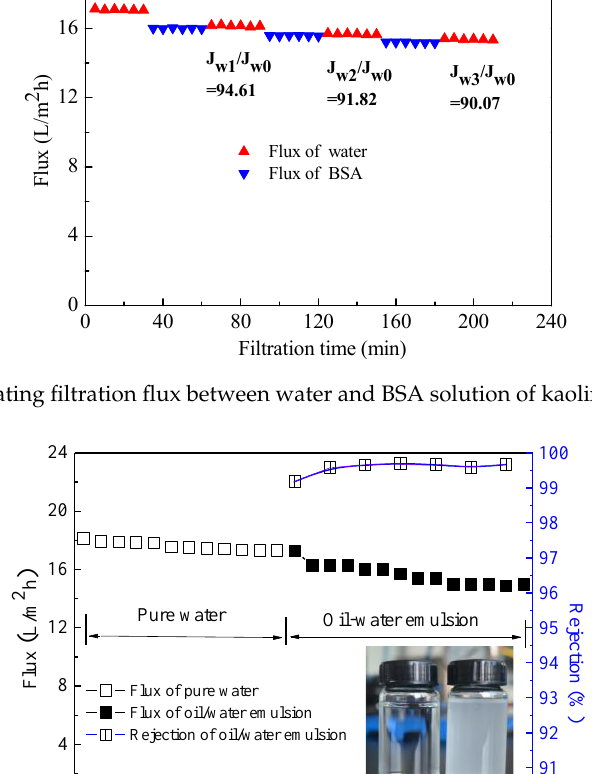
Coatings 2019 , 9 , x FOR PEER REVIEW 7 of 11